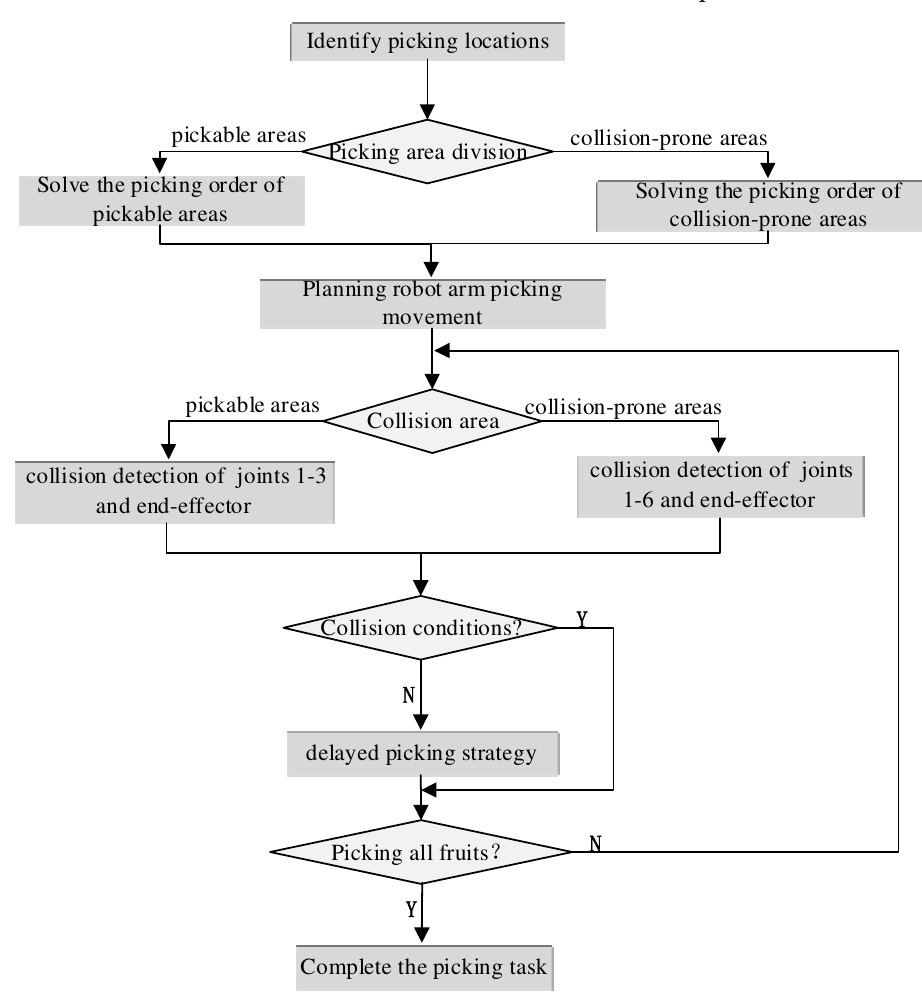
Figure 3. Flow diagram of the double-arm.